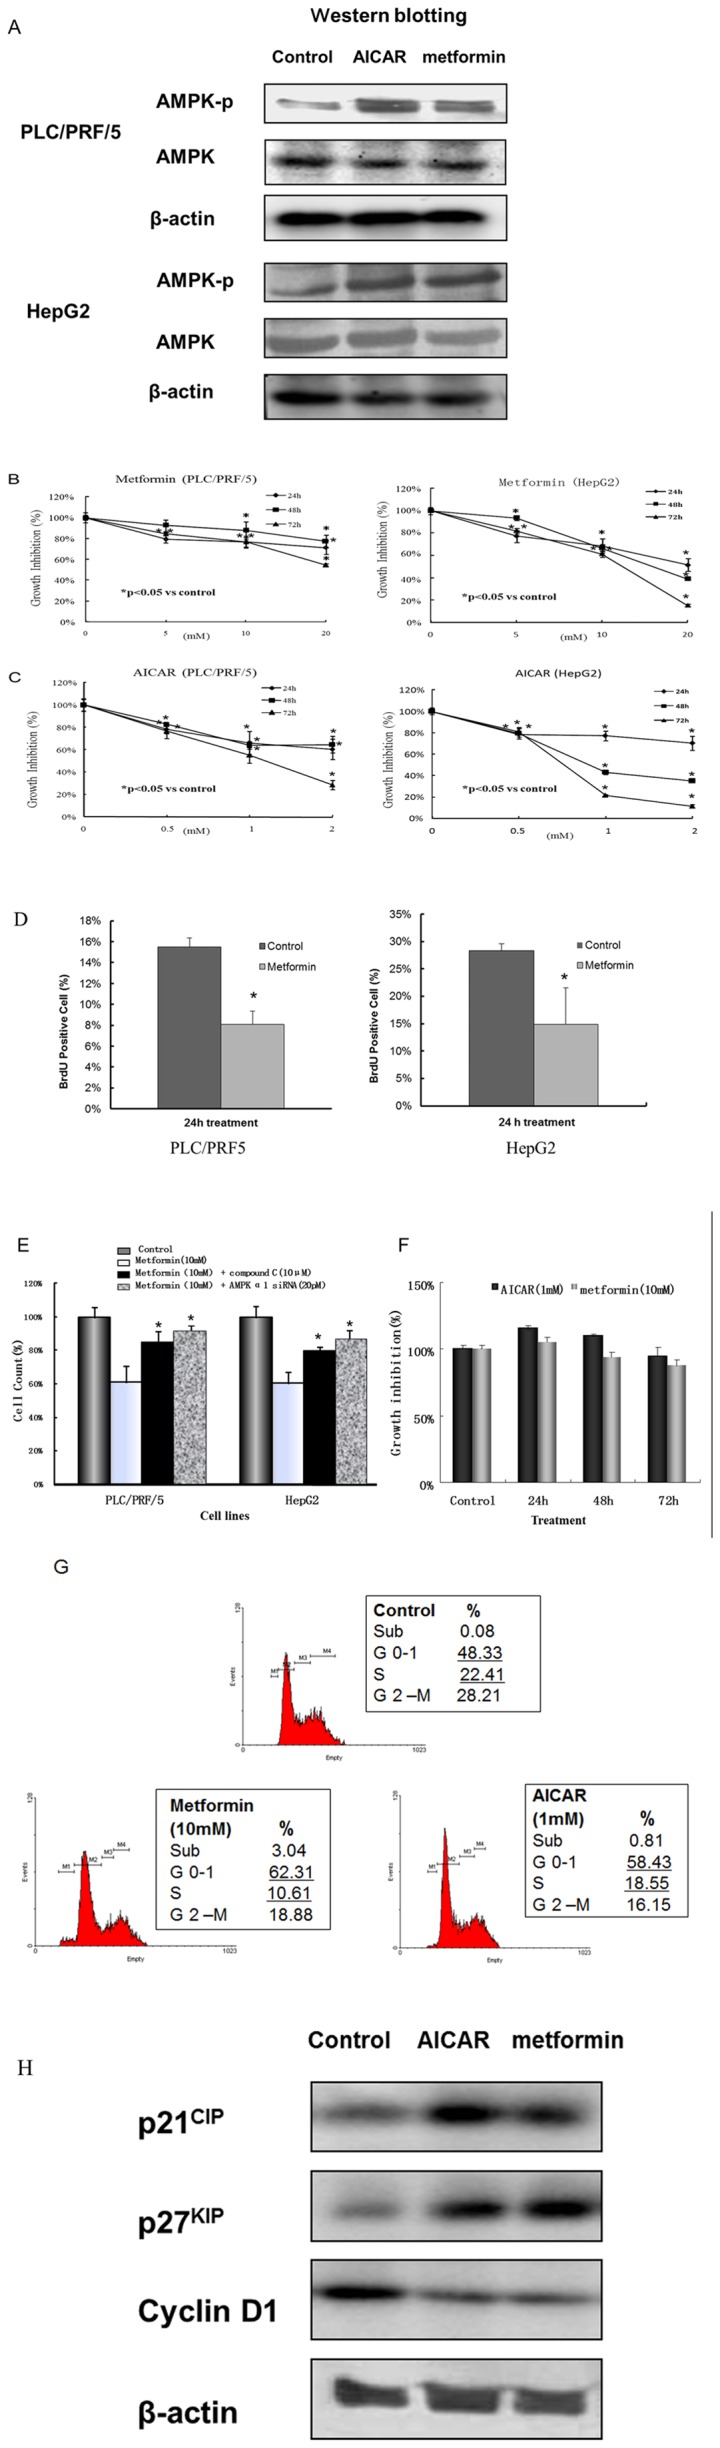
AMPK activity and cell proliferation in HCC cell lines, PLC/PRF/5 and HepG2.(A): Western blot analysis of phosphor-AMPK activation induced by AICAR (1 mM) and metformin (10 mM). Representative bands from three independent experiments. (B, C): Both AICAR and metformin inhibited cell proliferation in a time- and dose-dependent manner (MTT method) in PLC/PRF/5 and HepG2. *p<0.05 (vs. control). (D): BrdU incorporation was significant decreased in both of PLC/PRF/5 and HepG2 cells by metformin treatment for 24 h (E): Metformin inhibited cell proliferation and the growth inhibition was rescued by AMPKα1 siRNA and compound C (an AMPK inhibitor) treatment (cell count method). *p<0.05 (vs. metformin only). (F): As a control, LKB1 (the upstream activator of AMPK) absent cell line, Hela cells did not show growth inhibition with AICAR and metformin treatment. (G): Effect of AMPK activators on cell cycle arrest in HCC cells. Representative DNA histograms for PLC/PRF5 cells are shown. Data from three independent experiments are shown as mean ± SD. (H): Western blot analysis of p21CIP, p27KIP and cyclin D1 by AICAR (1 mM) and metformin (10 mM) treatment for 24 hours in PLC/PRF/5 cells.